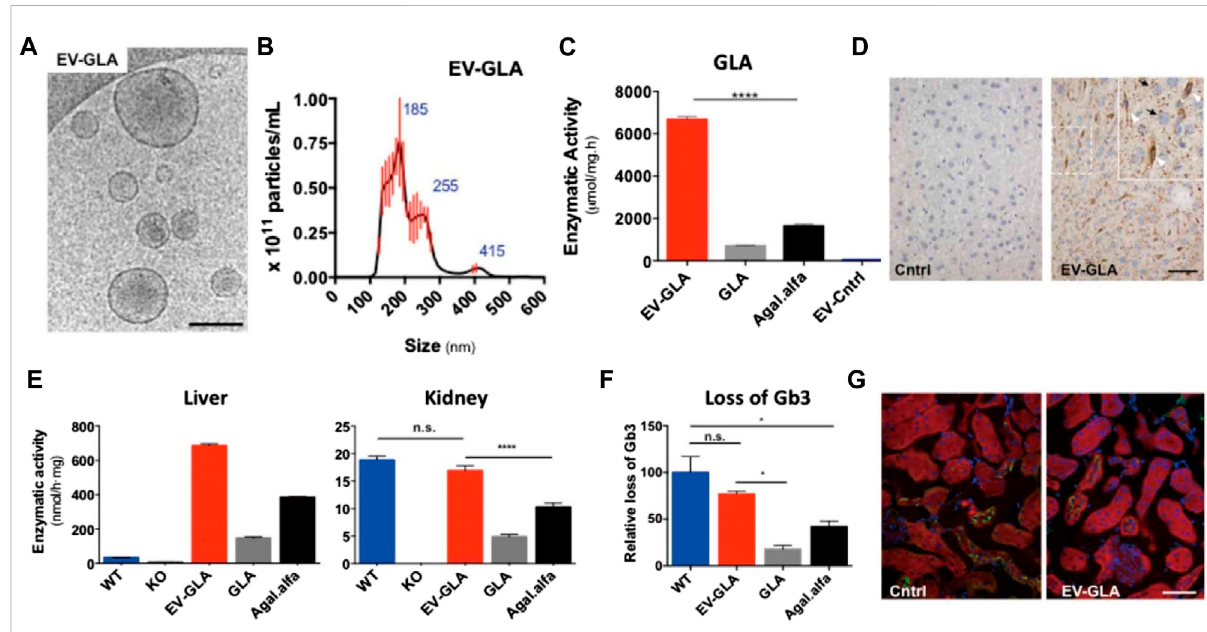
FIGURE 2 CryoTEM imaging (A) and size distribution (B) of EV-GLA. Scale bar: 200 nm. (C) α -GLA activity test for EV-GLA. (D) Immunohistochemistry for thedetection ofGLA enzymein livertissues of GLA knockout (KO)mice after theadministration of EV-GLA. Scalebar: 50 μ m. (E) Measurementof α - GLA activity in the liver and kidney of various groups. (F) Measurement of Gb3 loss in various groups. (G) Gb3 immuno fl uorescence (green signal) in the kidneys of KO mice after the administration of a single dose of EV-GLA. Scale bar: 40 μ m. Reproduced with permission (Seras-Franzoso et al., 2021). Copyright 2021, The